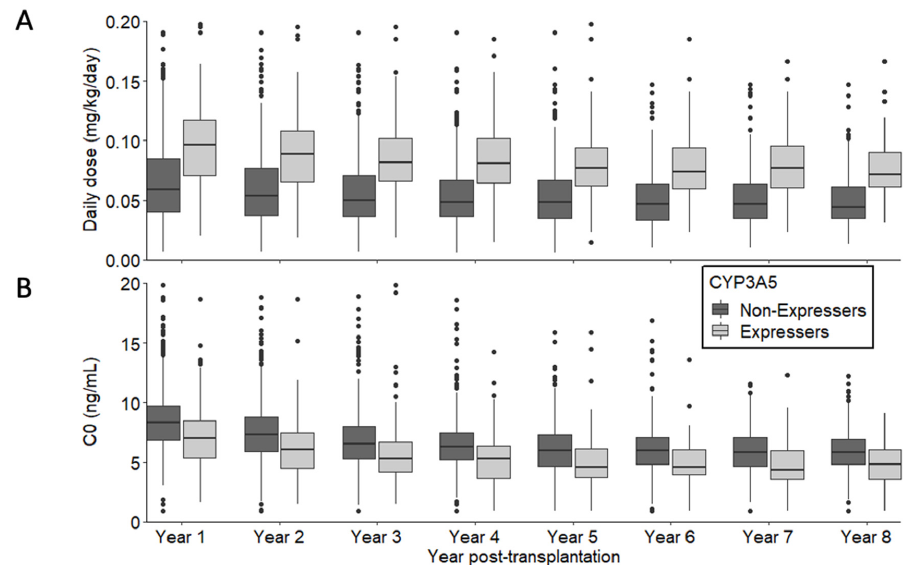
Figure 2. Description of tacrolimus daily dose ( A ) and C0 ( B ) from 1 year post-transplantation according to CYP3A5 expression.